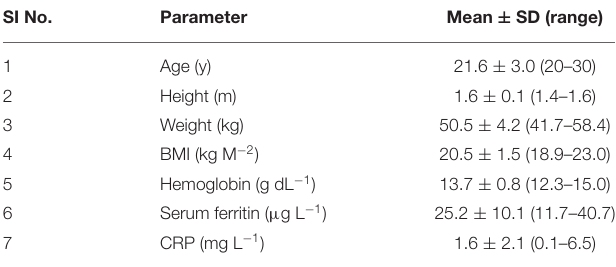
TABLE 4 | Baseline characteristics of the subjects. SI